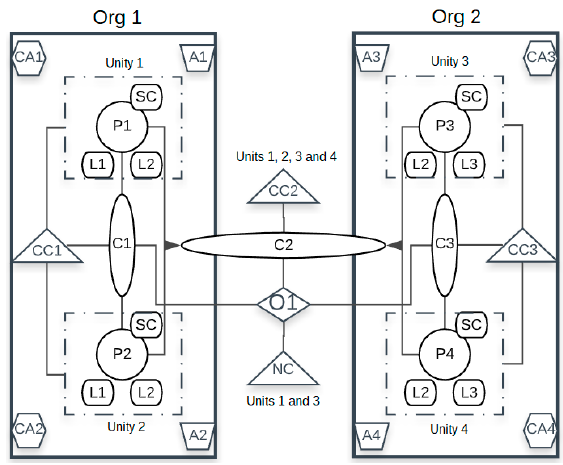
Figure A1. Network Topology based on Hyperledger Fabric.